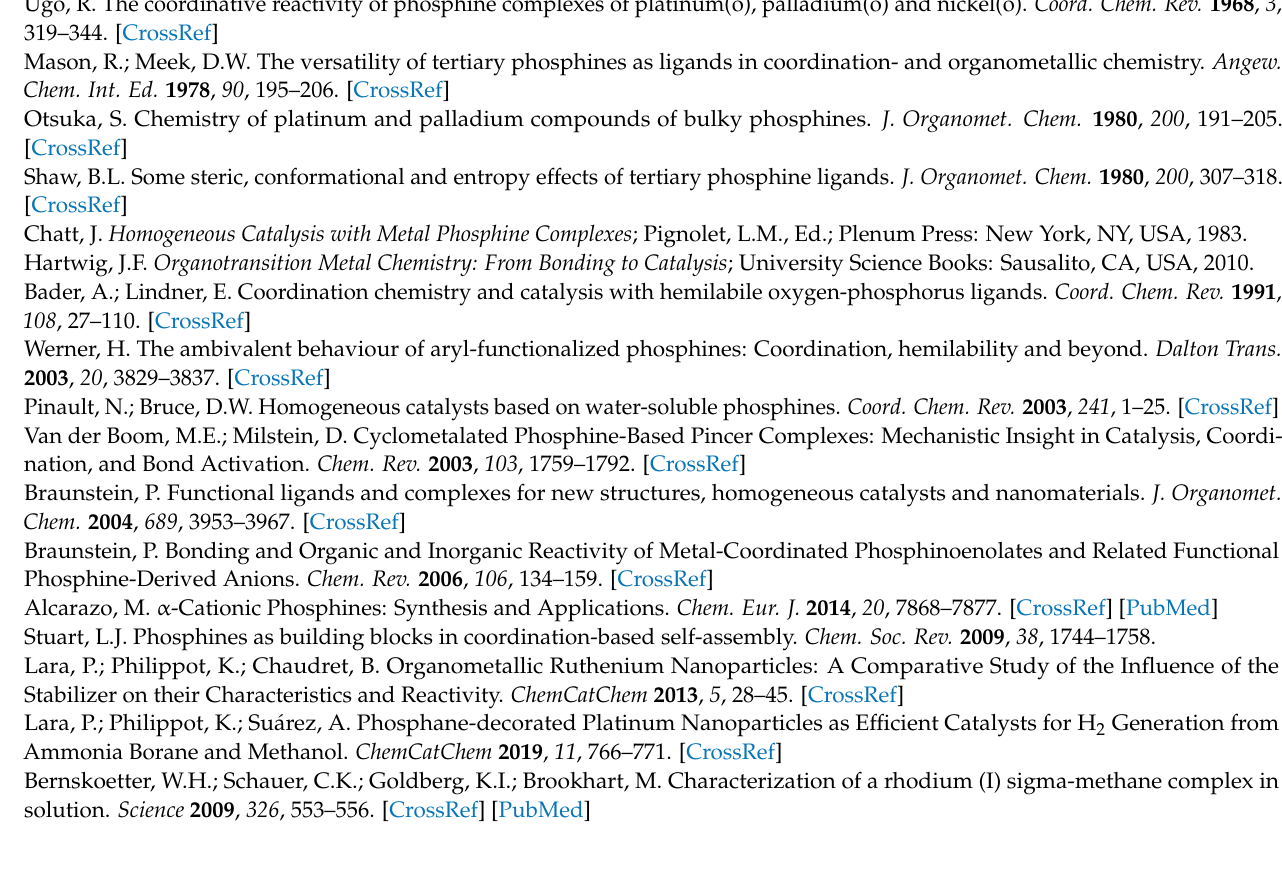
Table S3: Crystal data and structure refinement for compound 2